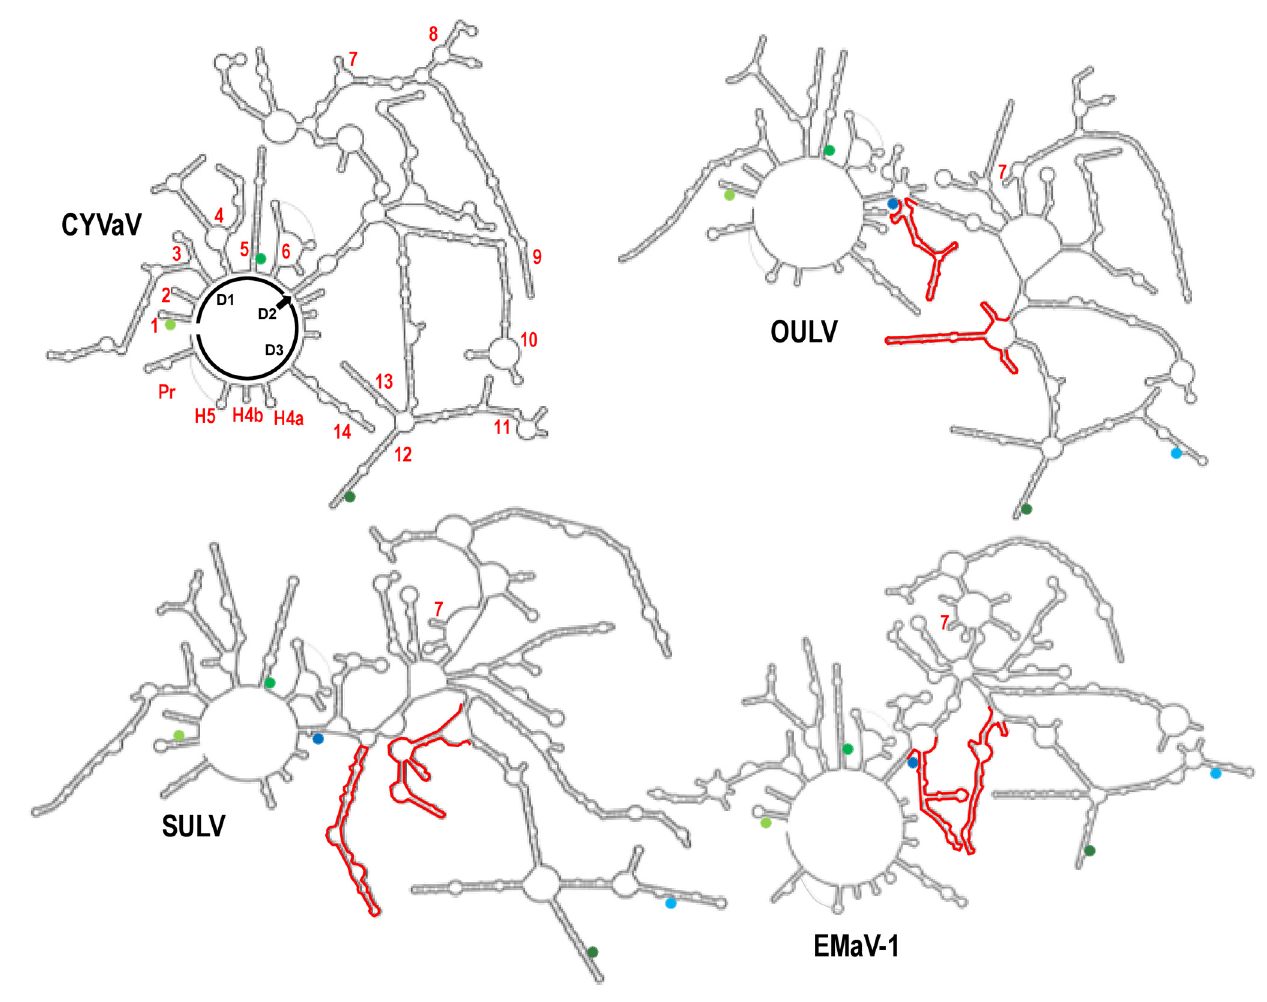
Figure 4. Comparison of the CYVaV RNA structure with proposed structures for other Class 2 ulaRNAs. See Figure 3 legend for explanation of numbers and domains shown for CYVaV. Additional designations of CYVaV structures (Pr, H5, H4a and H4b) can be found in Figure 12. Structure 7 (small hairpin) is highly conserved and is denoted for each genome structure. Inserted segments not found in CYVaV are shown in red. Light green, medium green and dark green circles denote ORF1 initiation site, ORF1 termination site and ORF2 termination site, respectively. Light blue and medium blue circles denote start site and termination site for ORF5, respectively.